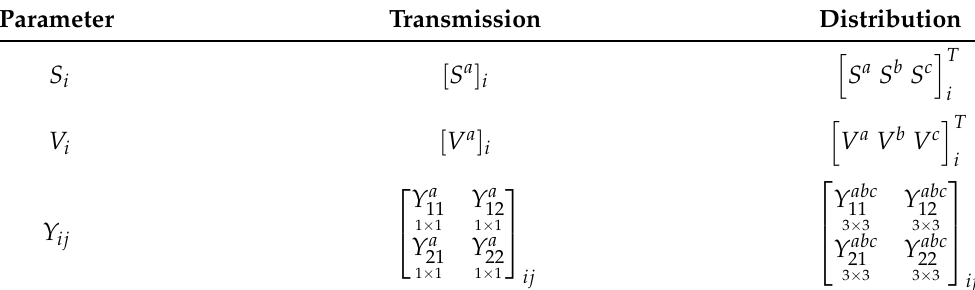
Figure 1. The substation transformer in an integrated network connecting a single-phase transmission bus k and a three-phase distribution bus m . Table 1. Representation of the parameters in transmission and distribution network